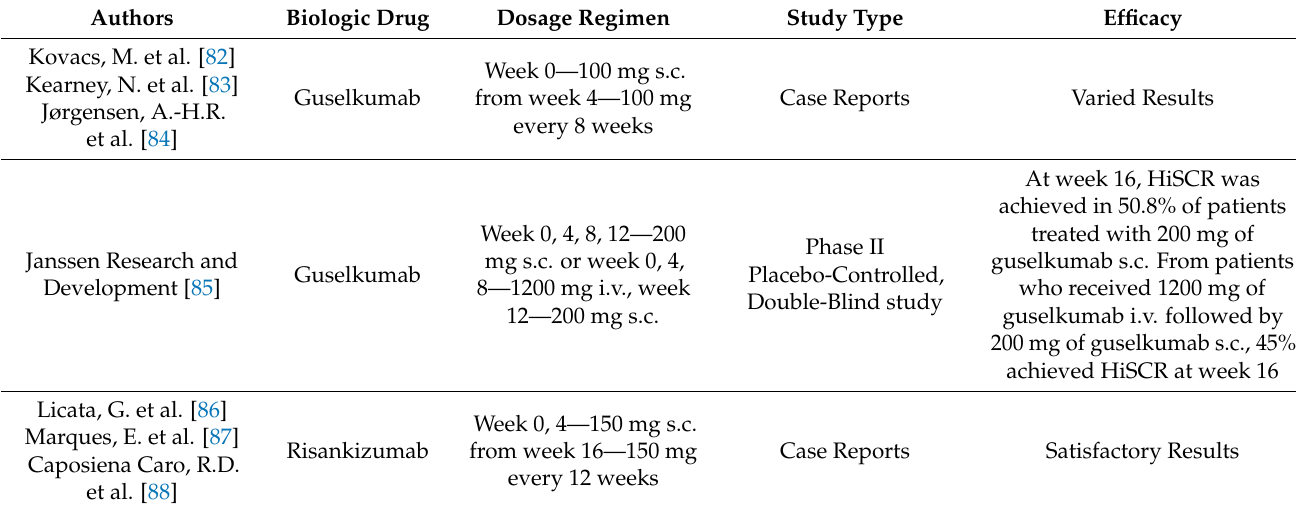
Table 3. A summary of significant clinical studies concerning the IL-23 inhibitors in